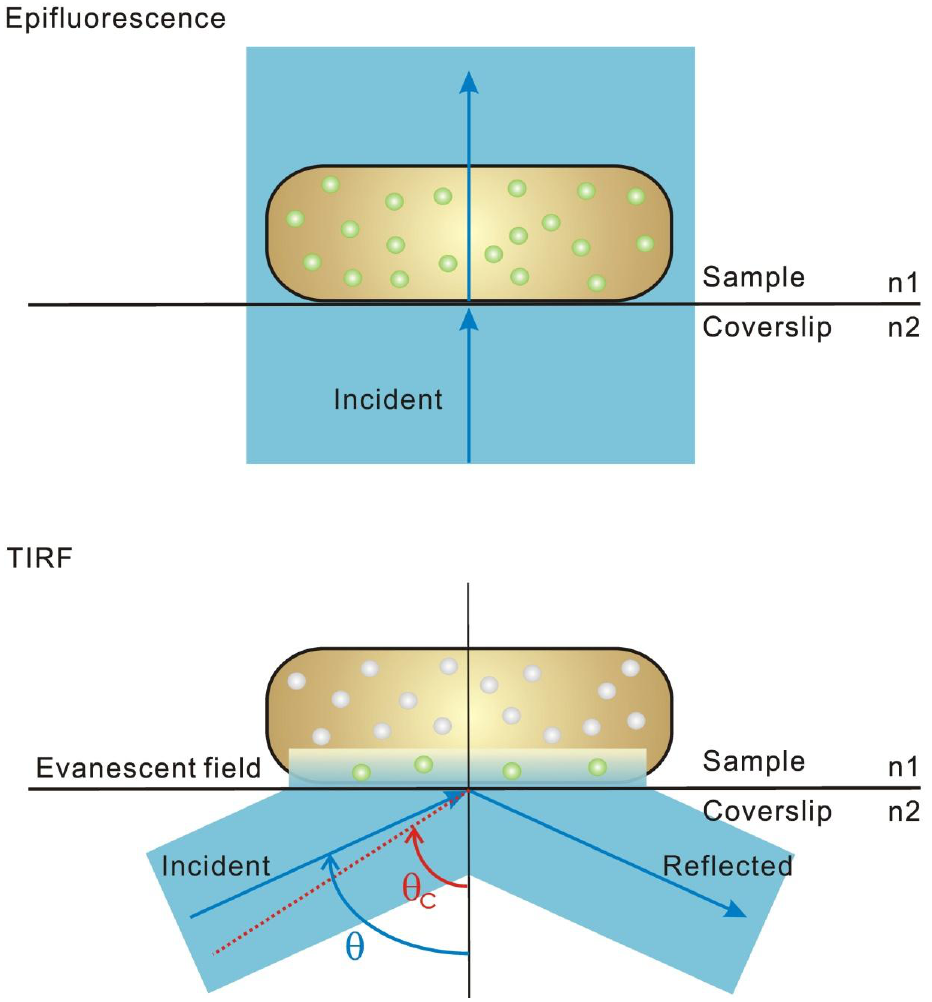
(red). When c , an c , typically 1.52 for 2